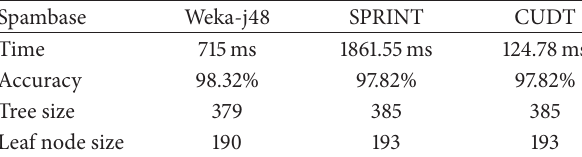
Table 2: Results of spambase.